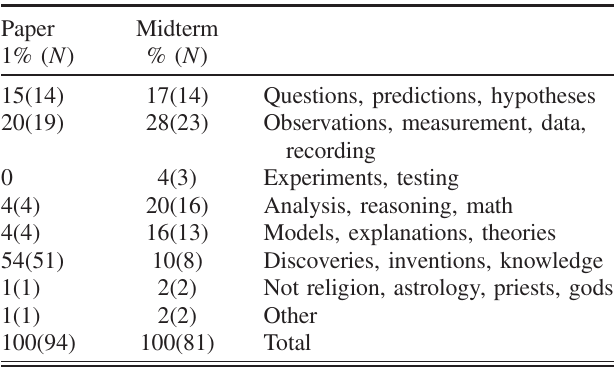
TABLE II. Evidence students used to argue that ancient people were scientists — compare first paper with